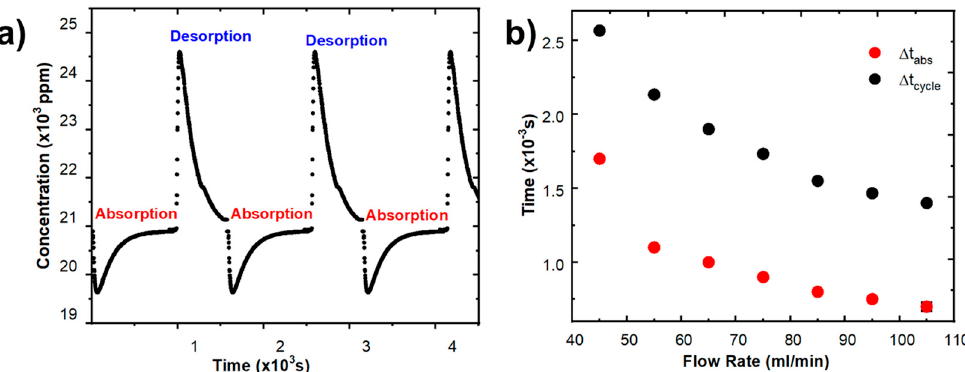
Figure 3. ( a ) Deionization cycles (charge–discharge) of CDI cell (85 mL/min, NaCl 0.4 M, 1.2 V). ( b ) Comparison between cycle time ( Δ t cycle ) and adsorption time ( Δ t abs ) as a function of flow rate (NaCl 0.4 M, 1.2 V).